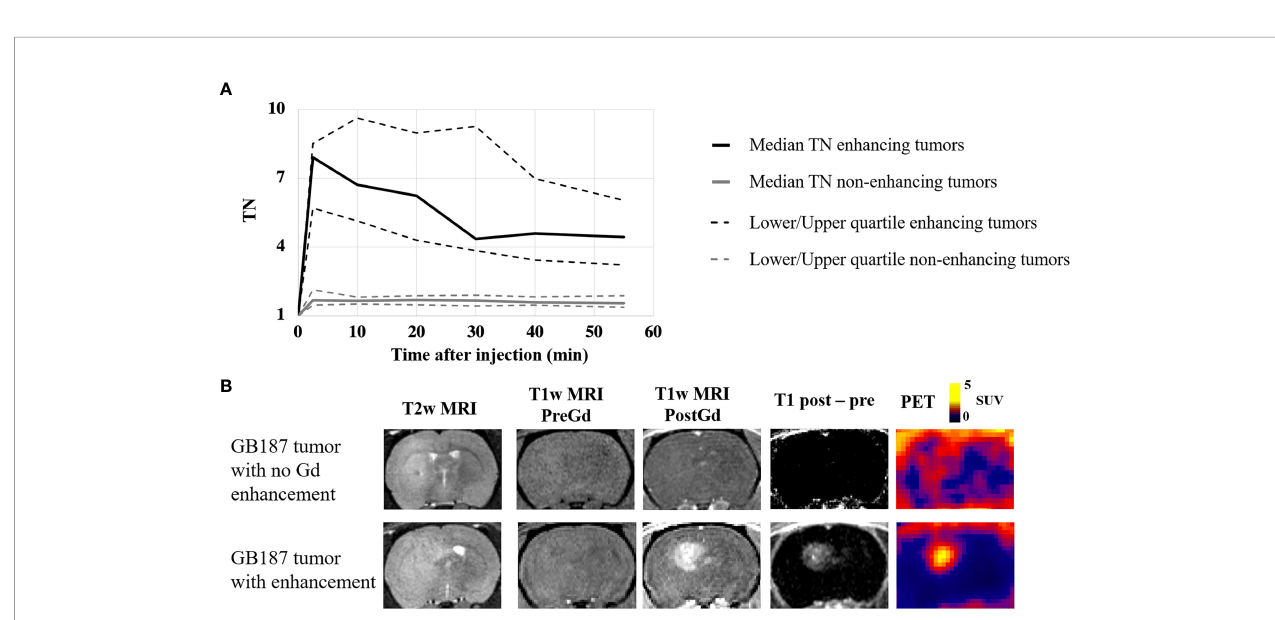
FIGURE 3 | (A) PET uptake curves showing the median tumor-to-normal brain uptake ratio (TN) for gadolinium enhancing and non-enhancing tumors in the study. Signi fi cantly greater PET uptake was found in the enhancing tumors at all timepoints. (B) Example coronal image slices for a rat with a GB187 luc non-enhancing tumor (top row) and a rat with a GB187 luc enhancing tumor (bottom row). The PET images were averaged frames for the time 15-35 minutes after injection. PET uptake is evident in both tumors, but the enhancing tumor has greater uptake than the non-enhancing